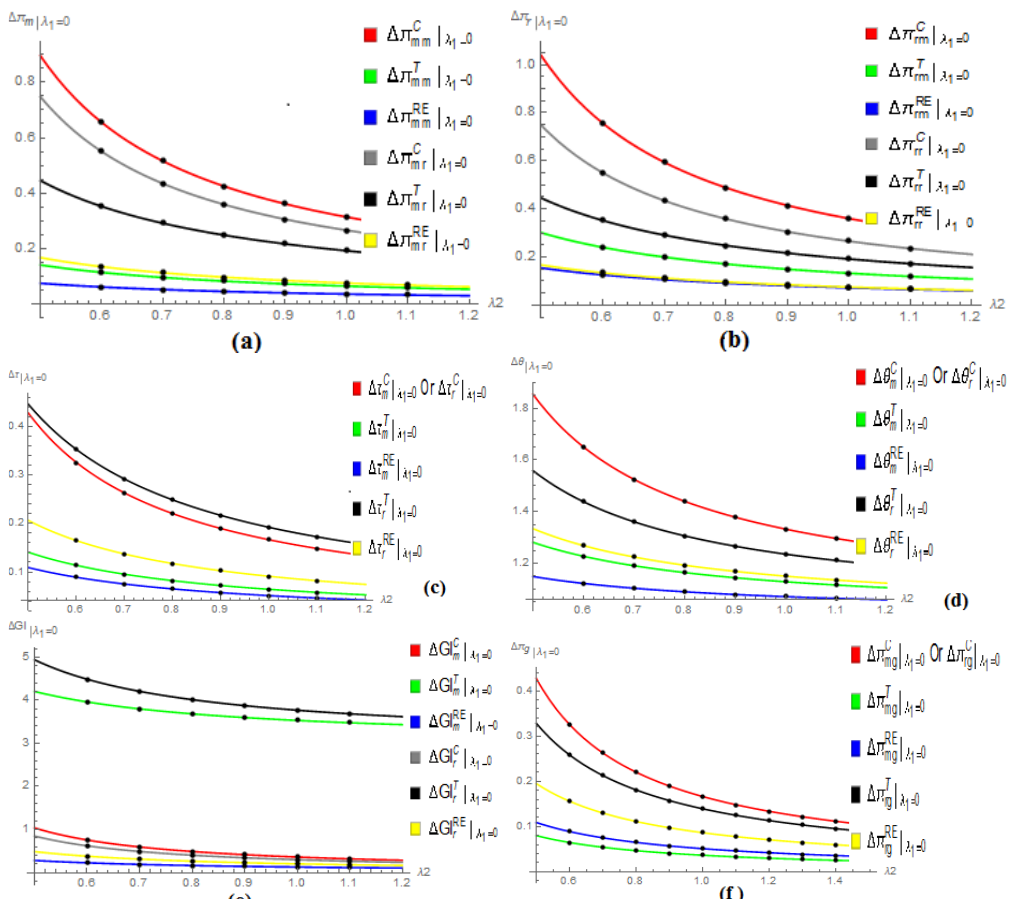
Figure 4. Graphical representation of ( a ) change in profits for the manufacturer, ( b ) change in profits for the retailer, ( c ) change in product collection rates, ( d ) change in greening levels ( λ 1 = 0), ( e ) change in amount of government subsidies, and ( f ) change in social welfare in Scenarios MC, RC, MRE, RRE, MT, and RT ( λ 1 =